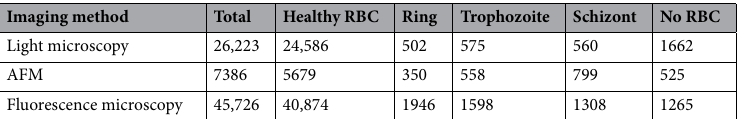
Table 2. Distribution of healthy RBCs, RBCs infected by the different malaria stages in the whole set of single-RBC images. The corresponding numbers are shown for all imaging methods used in the NN-based recognition. In addition, numbers for the “no RBC” images are also included.